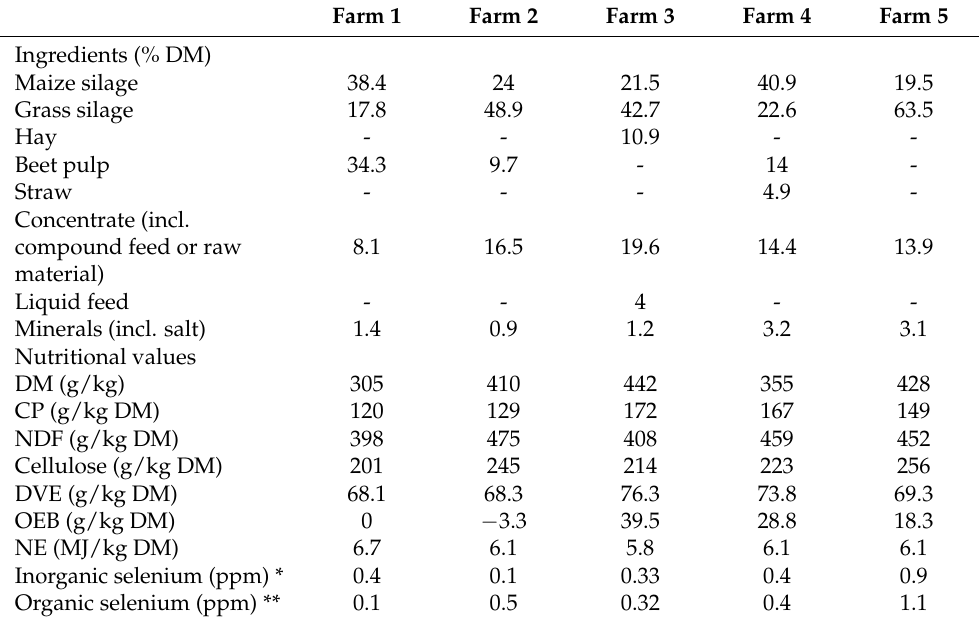
Table 1. Ingredients and nutritional values of the diets fed during